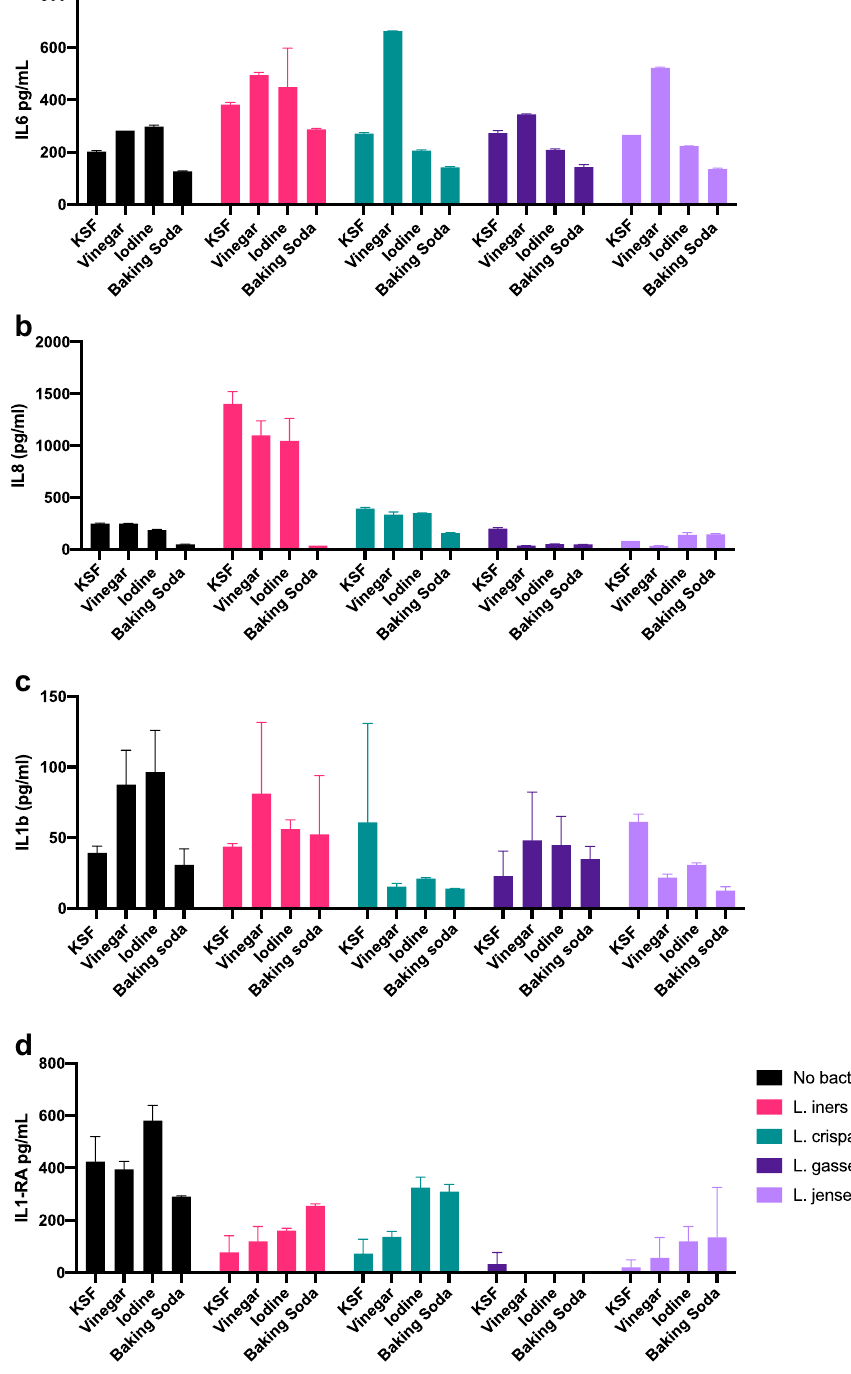
Figure 5. Impact of bacteria on vaginal epithelial cell death immune response to douching exposure. An immortalized vaginal epithelial cell line was cultured with a 25% solution of douching product diluted in the cell culture medium for 1 h, followed by replacement with a suspension of L. iners, L. crispatus, L. gasseri or L. jensenii (OD 0.1) in cell culture media for 23 h. Supernatant was used to measure IL6 ( a ), IL8 ( b ), IL1β ( c ) and IL1-RA ( d ) with ELISA, and values compared by ANOVA. Results are presented as mean ± SD from at least two separate